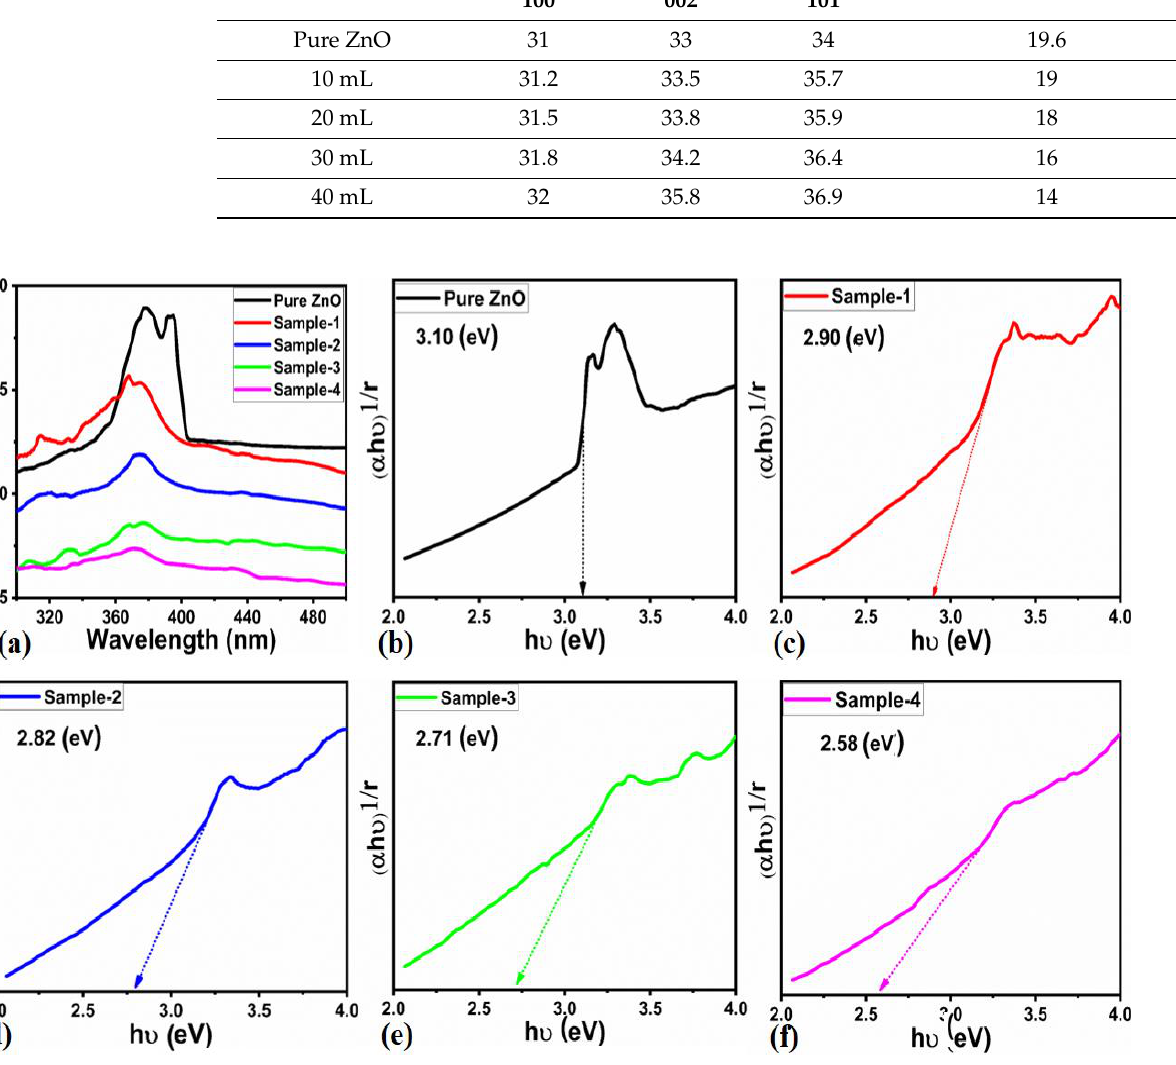
Figure 1. ( a ) Powder XRD patterns of pure ZnO and green synthesized ZnO samples prepared with various amounts of leafy extract of S. oleracea (10 mL, 20 mL, 30 mL, and 40 mL) ( b ) illustrates the shift in (100), (002) and (101) Bragg reflections of as-synthesized samples. Table 1. Calculated average crystallite size (nm) for pure ZnO and green synthesized ZnO samples prepared in the presence of various amounts of leaf extract of S. oleracea . Name of